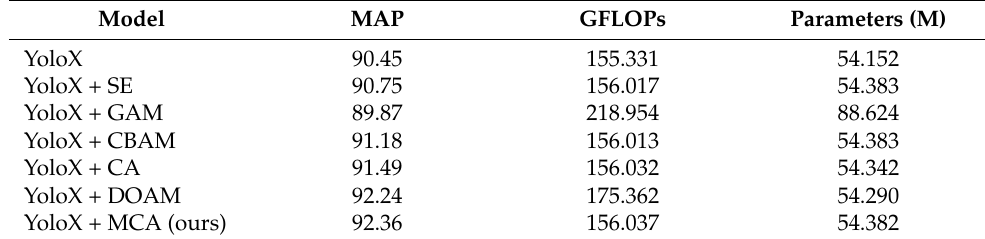
Table 3. Comparison of different attention mechanism modules.